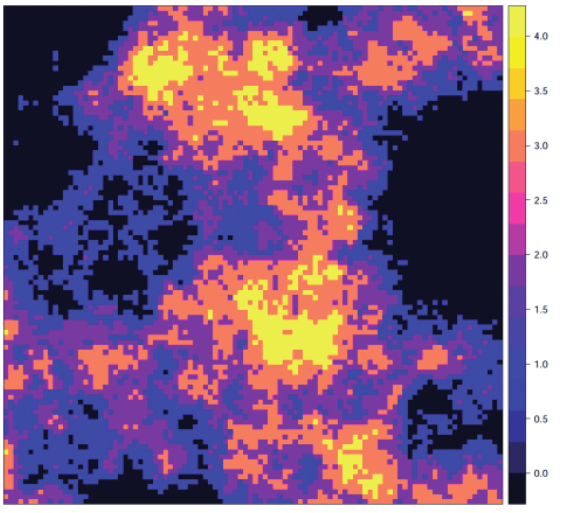
Figure 7. A spatial stratification of the area frame is shown. The stratification is obtained by selecting areas corresponding to differ- ent quantiles of the focus map as original distribution. In particular, the quantiles (0.25, 0.5, 0.75, 0.95) are used to generate 5 different strata. The first three strata have 2500 units each, the last two strata have respectively 2000 and 500